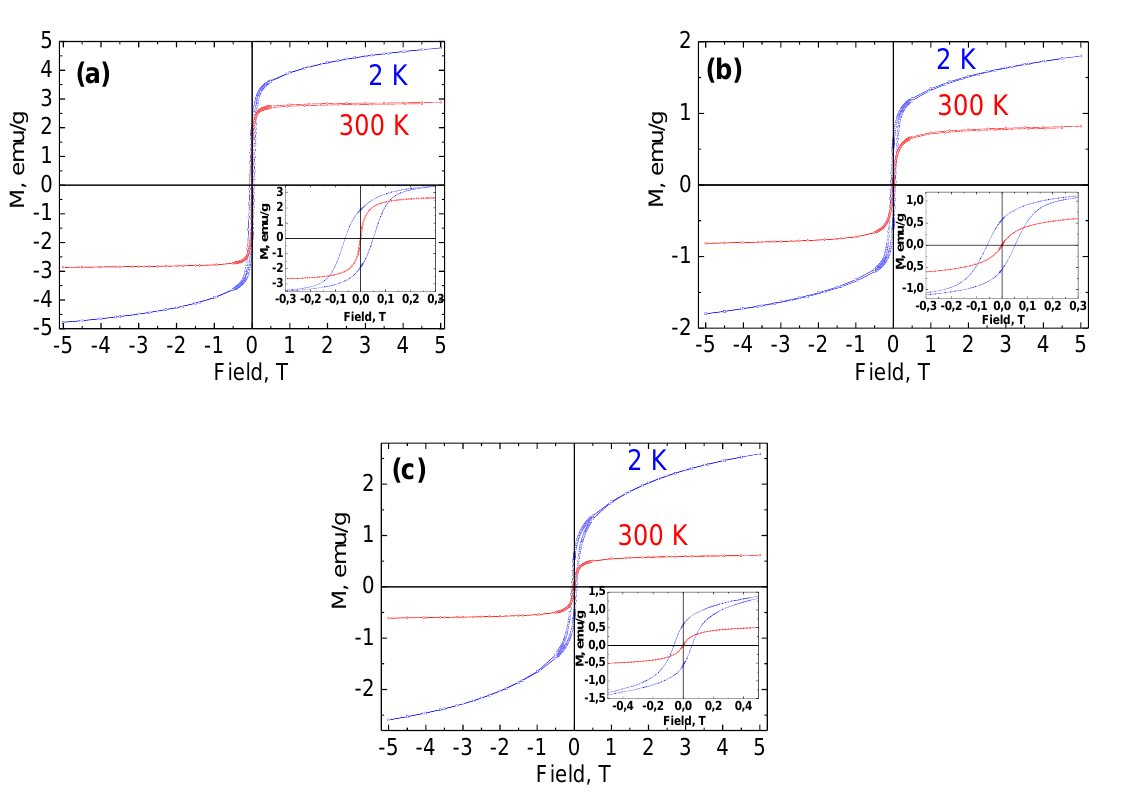
Figure 11. Magnetization versus applied field hysteresis loops measured for Ni NPs@PPP: H 200 ( a ), H 280 ( b ), and I 280 ( c ). The insets show the low field details of the cycles.